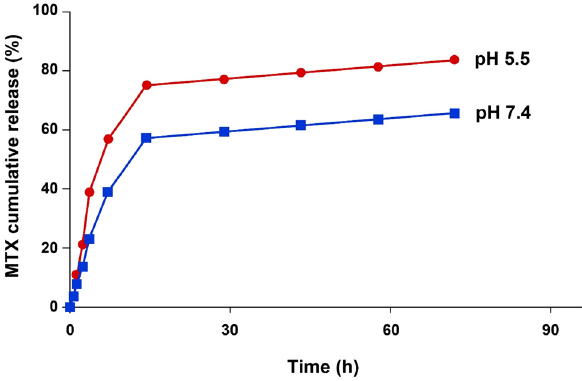
Figure 2: The MTX release pro fi le from the MTX - AS1411 - CS - AuNPs conjugate at pH 5.5 ( top line ) and pH 7.4 ( bottom line ) .